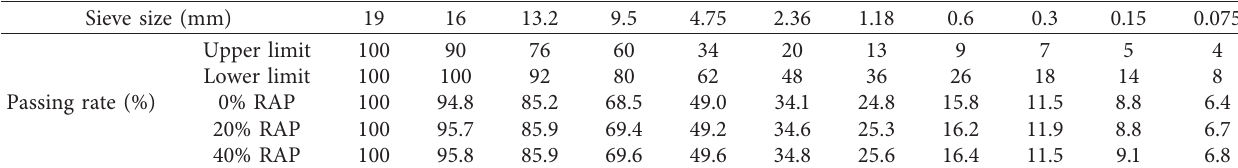
Table 5: Asphalt mixture gradation.